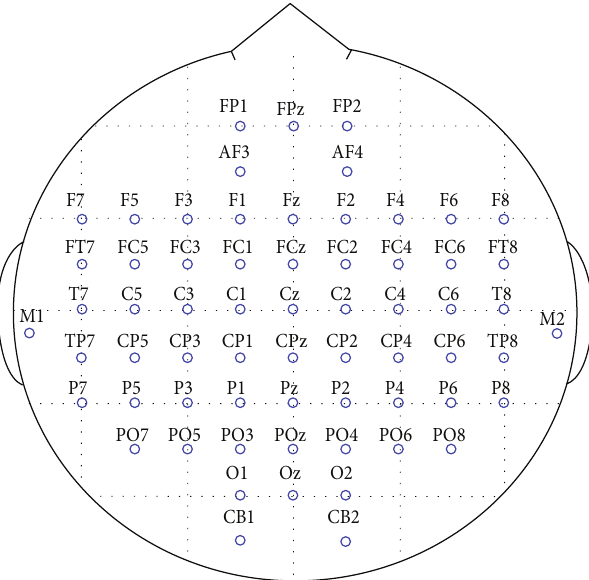
Figure 1: Electrode placement in accordance with 64CH interna- tional 10–20 system.